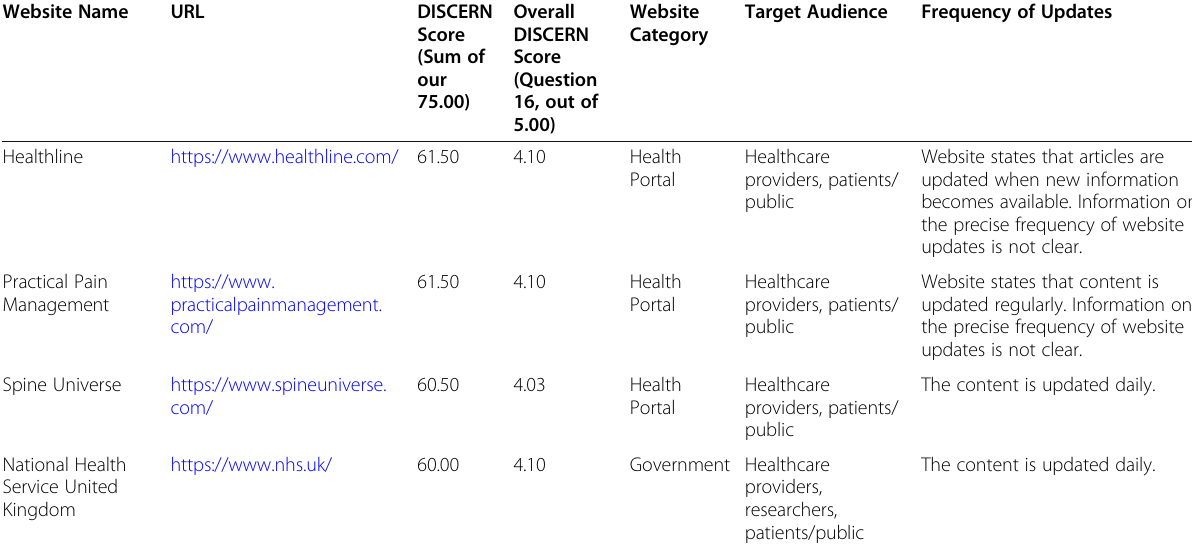
Table 3 Recommended Websites for Patients and Consumers